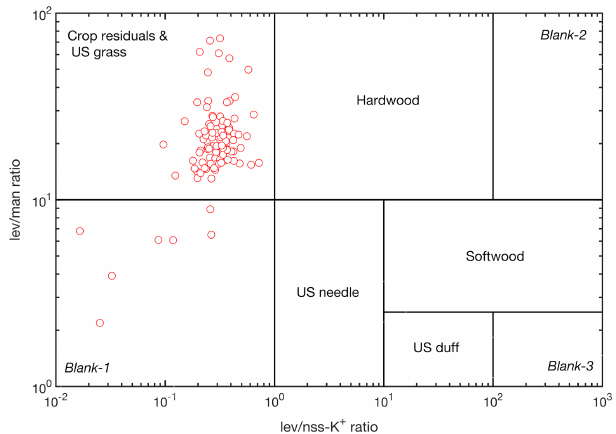
Figure 6. Representative ranges of lev / nss-K + and lev / man ra- tios for different types of biomass fuel introduced by Cheng et al. (2013). Results from the ambient samples collected in this study are also shown for